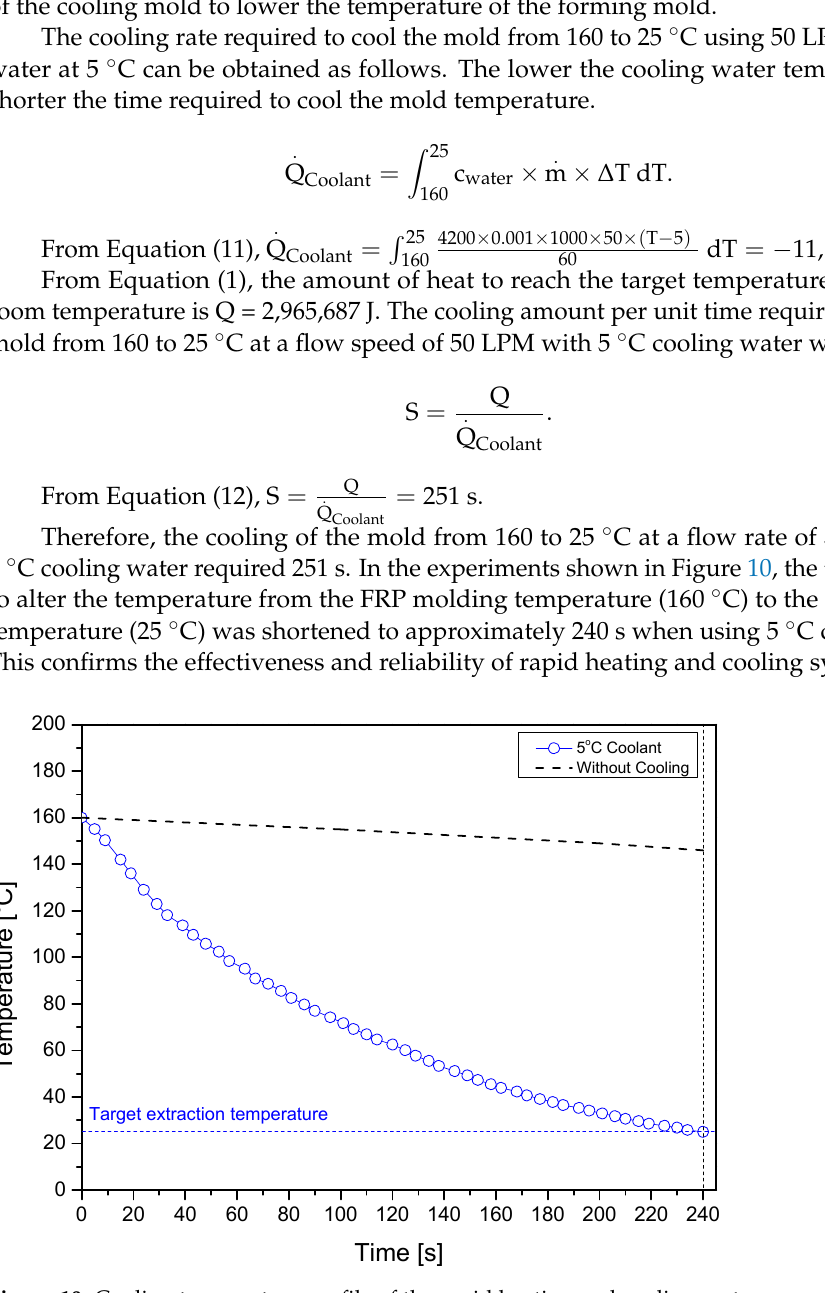
Figure 11. Input system to load the FRP material. The molded WLF helical gear was difficult to extract because of the helix angle to the extraction direction. The extraction cylinder of the lower frame raised the lower guide